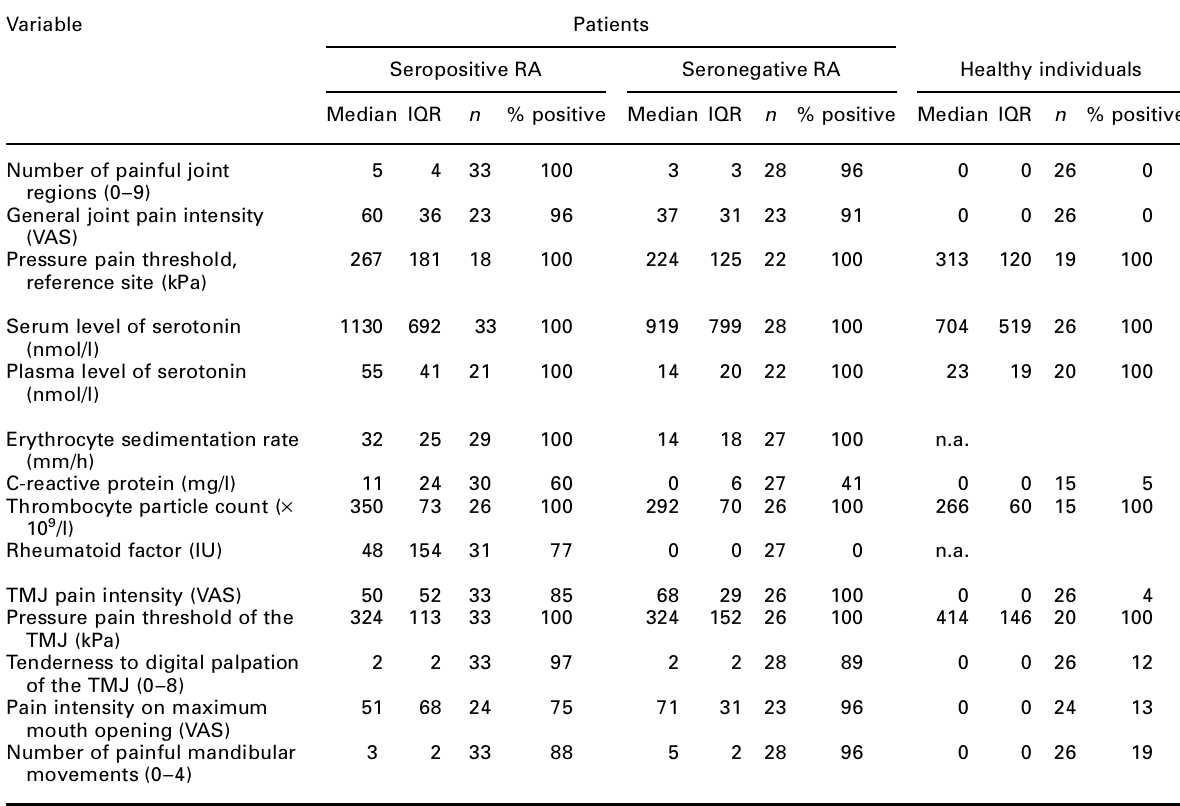
Table 2. Median, interquartile range (IQR), number of observations ( n ) and percent observations exceeding 0 (% positive) regarding clinical and blood variables in 33 patients with seropositive RA, 28 patients with seronegative RA and 26 healthy individuals